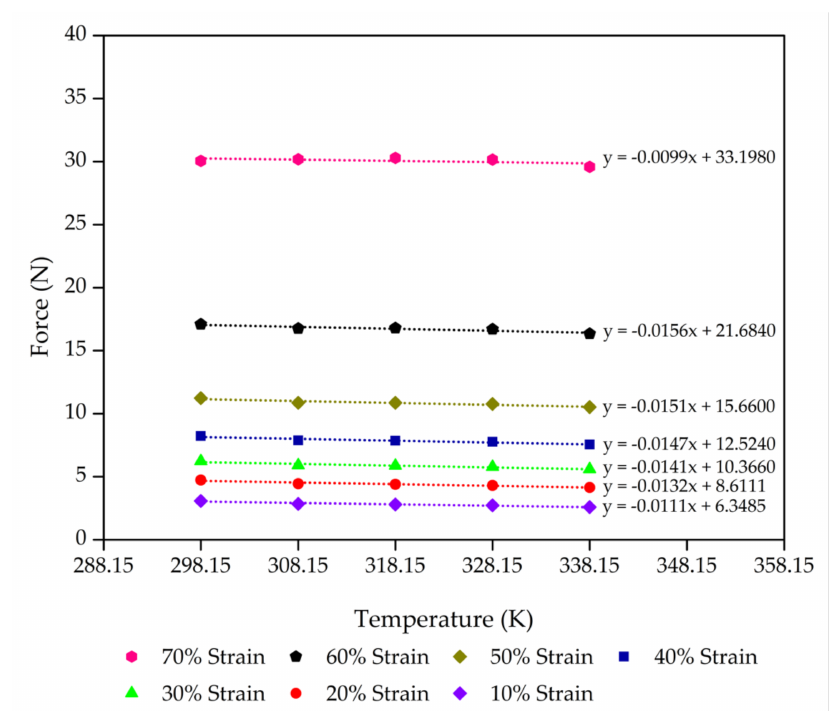
Figure 4. Compression force as a function of the temperature of the control sample from 10% to 70% compression strain with a minimum linear regression (R 2 ) = 0.9 at each strain. The scatter on the results is on the order of the size of the data points.